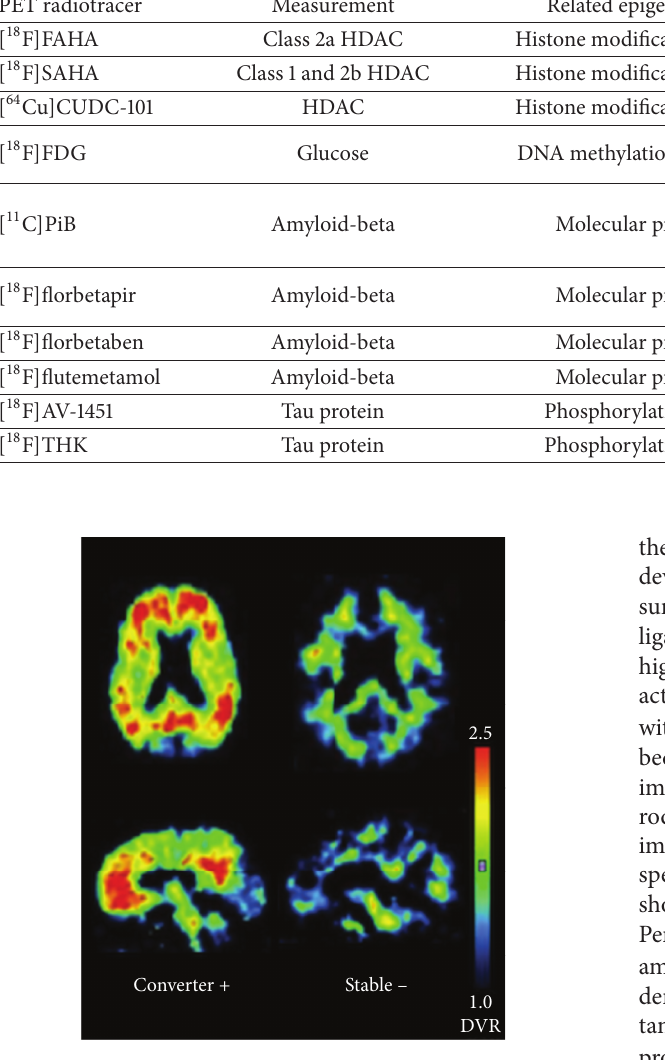
Figure 6: Transverse and sagittal PiB-PET scans from 2 patients with different degrees of amyloid-beta deposition. This image originates from a study examining patients with mild cognitive impairment (MCI) using positron emission tomography in com- bination with the radiotracer Pittsburgh compound B. It is noted that the PiB distribution volume ratio (DVR) of the patient that has progressed from MCI to AD (converter) is positive for amyloid-beta and shows a significant DVR, while the patient that is stable with MCI and has not progressed to AD (stable) is negative for A 𝛽 and shows a lower DVR ([62], reprinted with